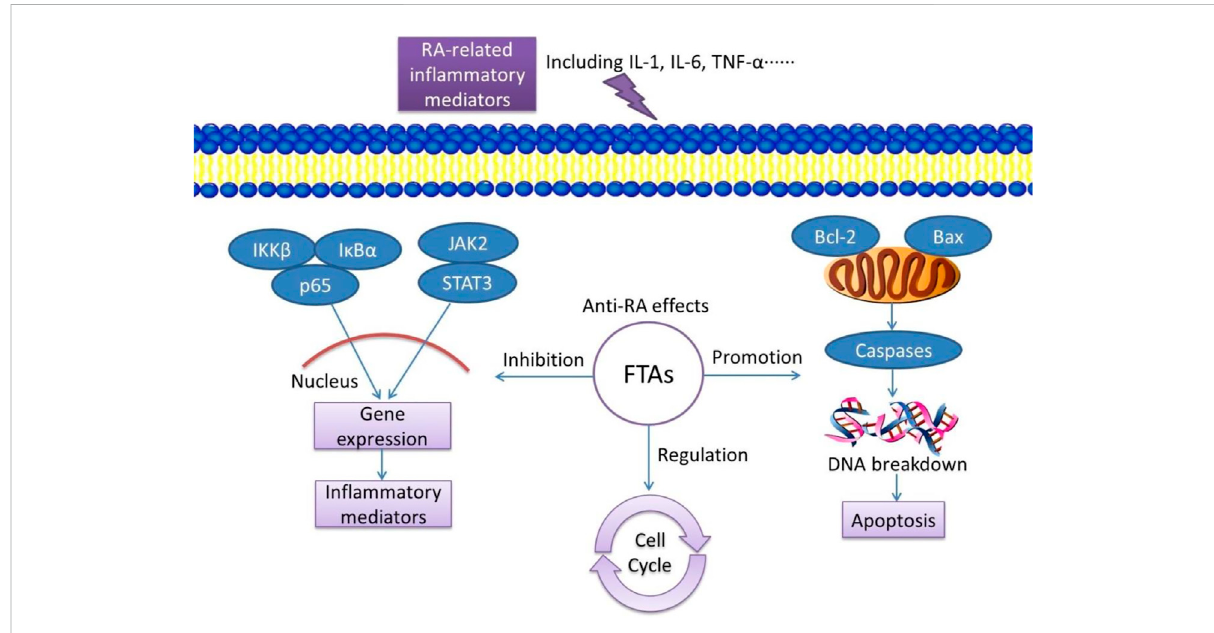
Schematic diagram of FTAs exert anti-RA effects by regulating in fl ammatory signaling pathways, promoting cell apoptosis and inhibiting cell